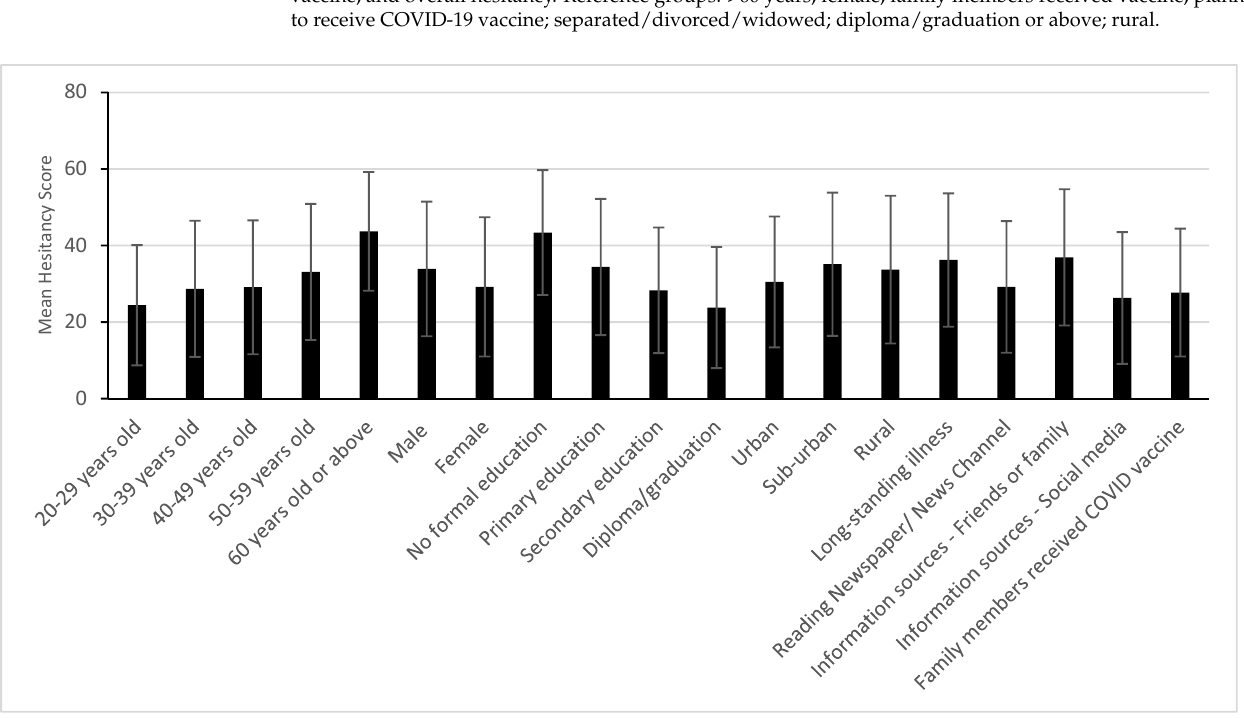
Figure 2. Comparison of hesitancy score (using mean and standard deviation) between patient-related factors among unvaccinated patients. Note: score range: 11–55; the higher the score, the more hesitant the person. Table 5. Multivariate l ogistic regression examining the association of patient-related factors with vaccine acceptance and hesitancy.